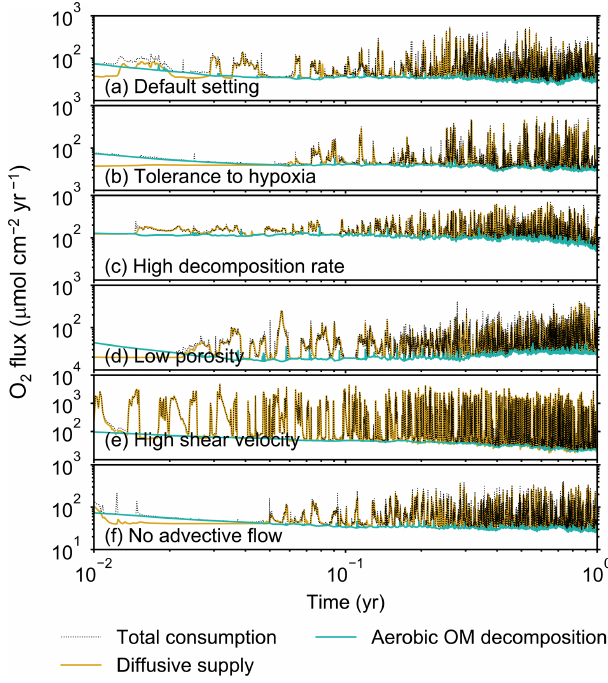
Figure 5. Time evolution of oxygen fluxes obtained from 1-year simulations with eLABS. See Sect. 3.1 and caption of Fig. 4 for the details of simulations (a–f) . Black dotted curves represent the to- tal oxygen consumption fluxes, orange curves the fluxes of oxygen supply via molecular plus eddy diffusion, and turquoise curves the oxygen consumption fluxes through aerobic degradation of organic matter. Note that the scale of vertical axis is different in panel (e)